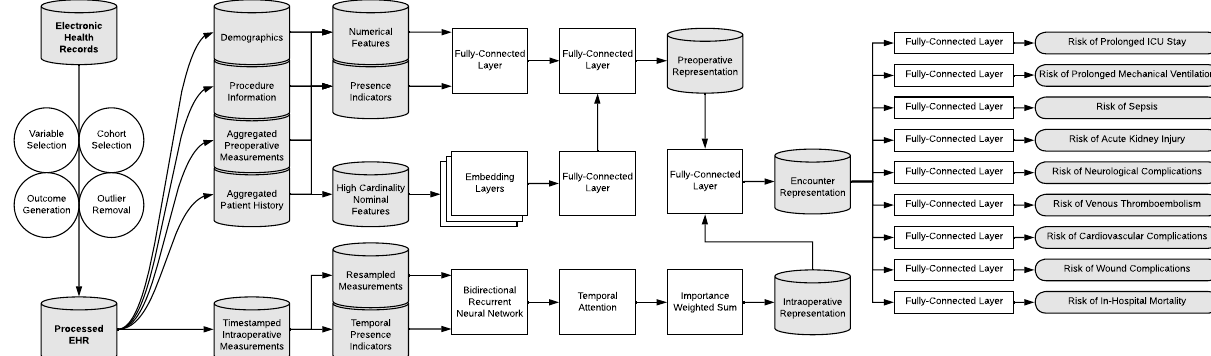
Figure 3. Data processing pipeline and deep learning model architecture. Patient-level input variables were split into static preoperative data and temporal intraoperative data. Preoperative variables were split into continuous, binary, and high-cardinality features and followed variable-specific preprocessing procedures. Deep learning model architecture utilized a data fusion design combining latent representations of high-frequency intraoperative data (from a bidirectional recurrent neural network) and static preoperative patient data (from fully connected layers) for eventual multi-task prediction of nine postoperative